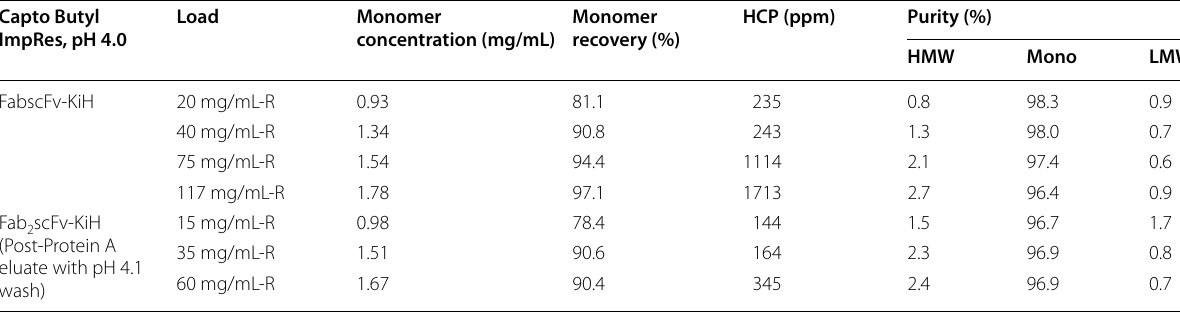
Fab 2 scFv-KiH (Post-Protein A eluate with pH 4.1 wash)